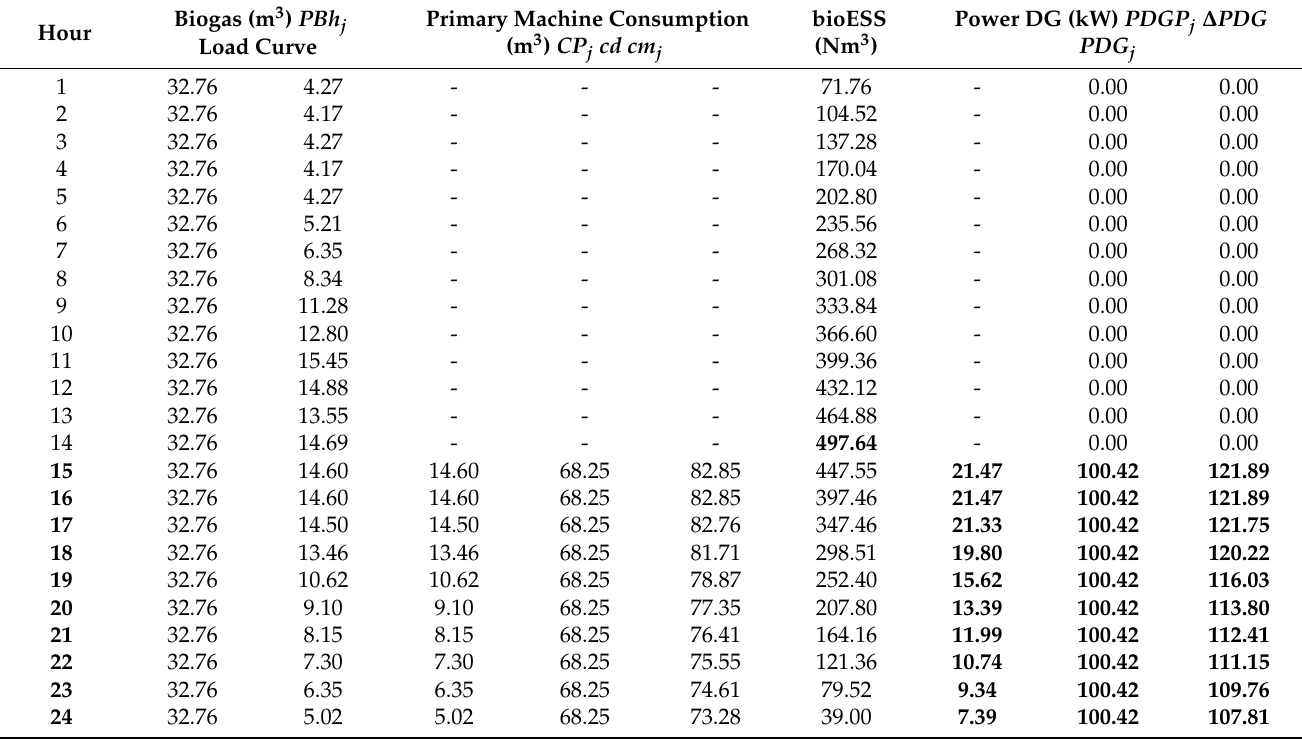
Table 2. Detailed results for Case 1 (MOR Model 1 with one operating range).